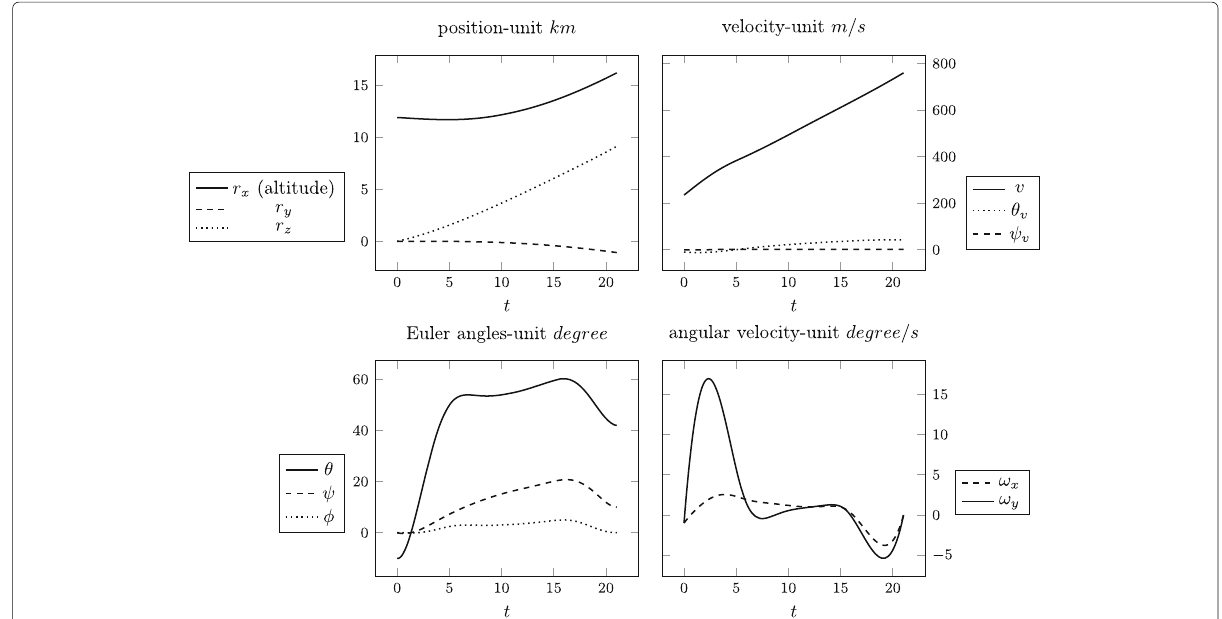
Fig. 17 Time history of state variable x ( t ) during the pull-up